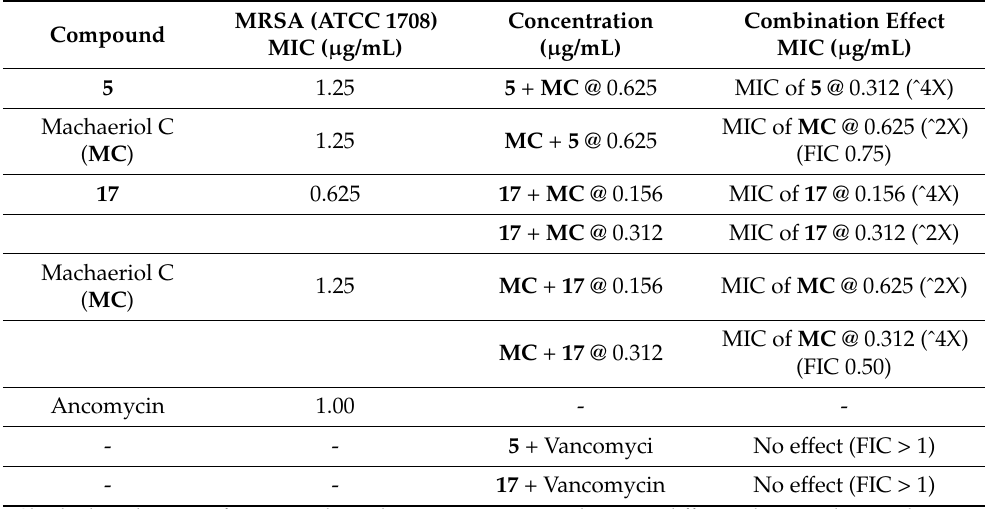
Table 2. Combination study of compound 5 and 17 with machaeriol C by checkerboard* assay against MRSA.